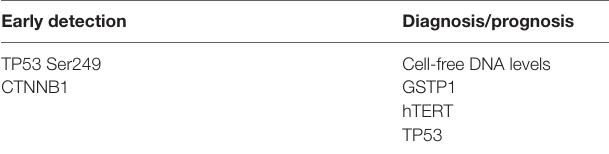
TAbLe 1 | Circulating DNA biomarkers explored in hepatocellular